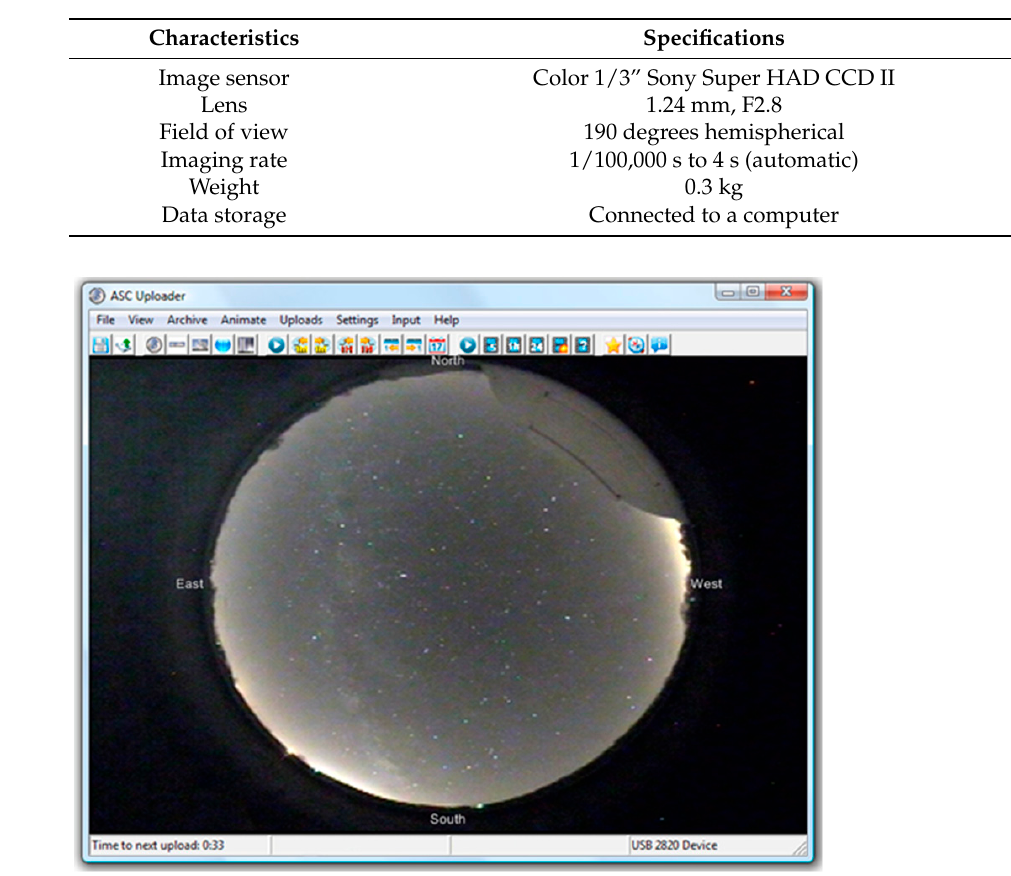
Figure 2. A snapshot of the ASC Uploader [21]. The outputs of the all-sky imager are in 24-bit JPEG format, at a resolution of 576 × 720 pixels. It is well known that the JPEG format is not a preferred format because of data loss caused by compression. However, in this study, we still utilized JPEG format images since the format of the output image is unchangeable. The all-sky image database at PER- MATApintar observatory consists of images taken since April 2013. The archiving interval was initially set at an hourly basis, meaning that 24 all-sky images were taken and stored every day. An example of the all-sky image is shown in Figure 3a, which was taken on 17th May 2013 at 1900 LT.